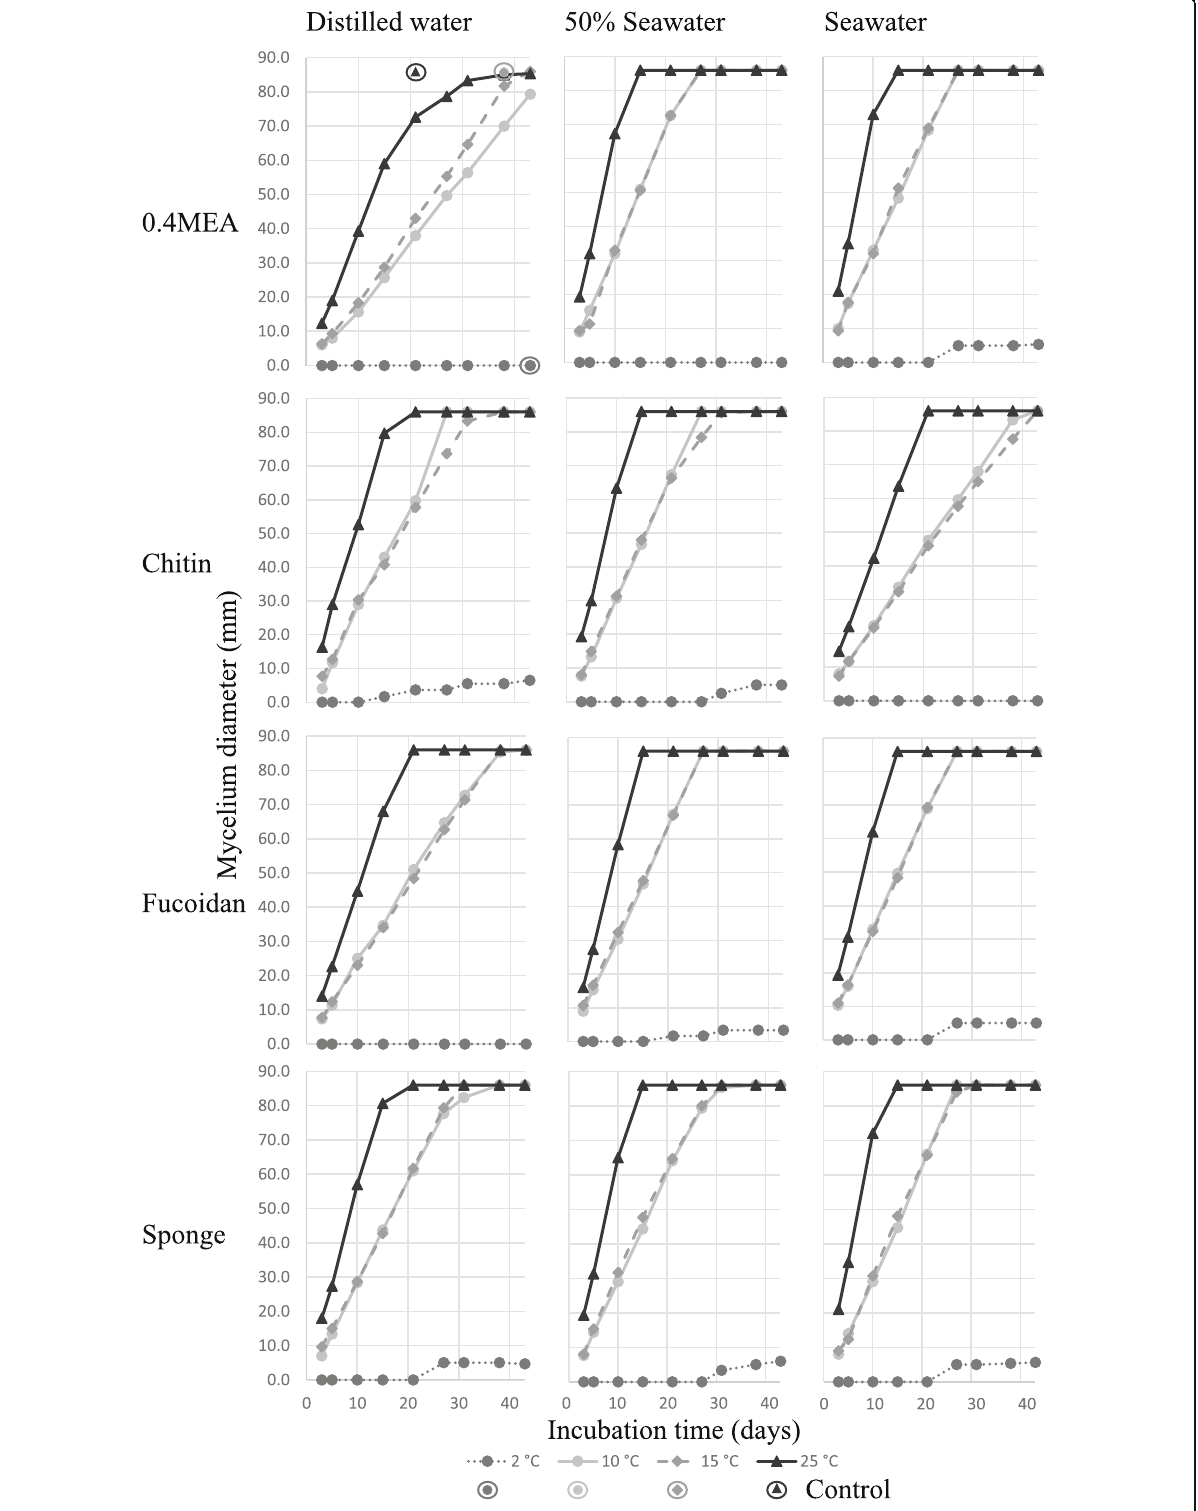
Fig. 2 Growth characterization of Emericellopsis sp. TS7 using four different substrates and three different salinities incubated at four different temperatures. Maximum growth was 86 mm. Max growth of growth control on distilled water agar is shown in the first panel with encircled symbols. The control for 10 °C and 15 °C is